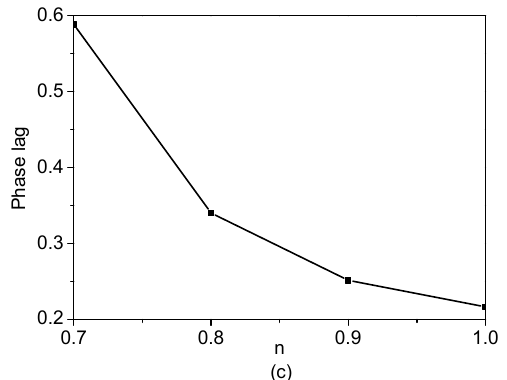
Figure 7. Comparison of the velocity evolution at the transverse center ( z = y = 0) of the microchannel for different values of flow behavior index ( n = 0.7, 0.8, 0.9, 1.0) under an AC electric field with E 0 = 1, ω π = and ψ w = − 1. ( a ) Start-up characteristics of the electroosmotic velocity; ( b ) Steady-state oscillation of the electroosmotic velocity; ( c ) Variation of the phase lag between velocity and AC field with the fluid behavior index at the steady-state oscillation.